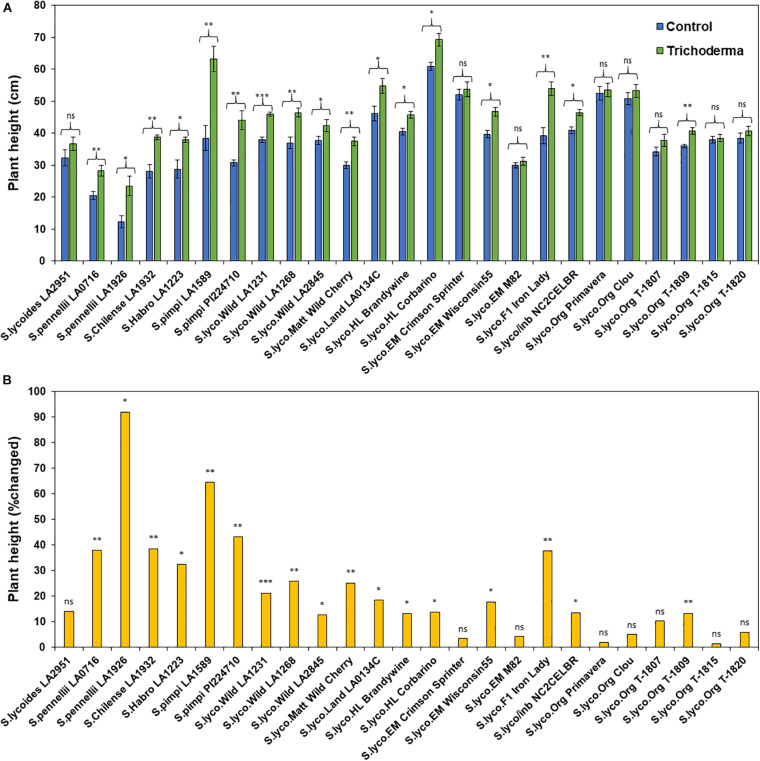
Effects of Trichoderma treatment on (A) plant height (cm) in a set of diverse tomato genotypes. Graph (B) represents the percentage in plant height changed by Trichoderma treatment in comparison with the control treatment. Asterisks indicate significant differences in plant height in the Trichoderma-treated versus control plants using the Student’s t-test at a ∗P ≤ 0.05, ∗∗P ≤ 0.01 and ∗∗∗P ≤ 0.001. Bars represent the standard error.